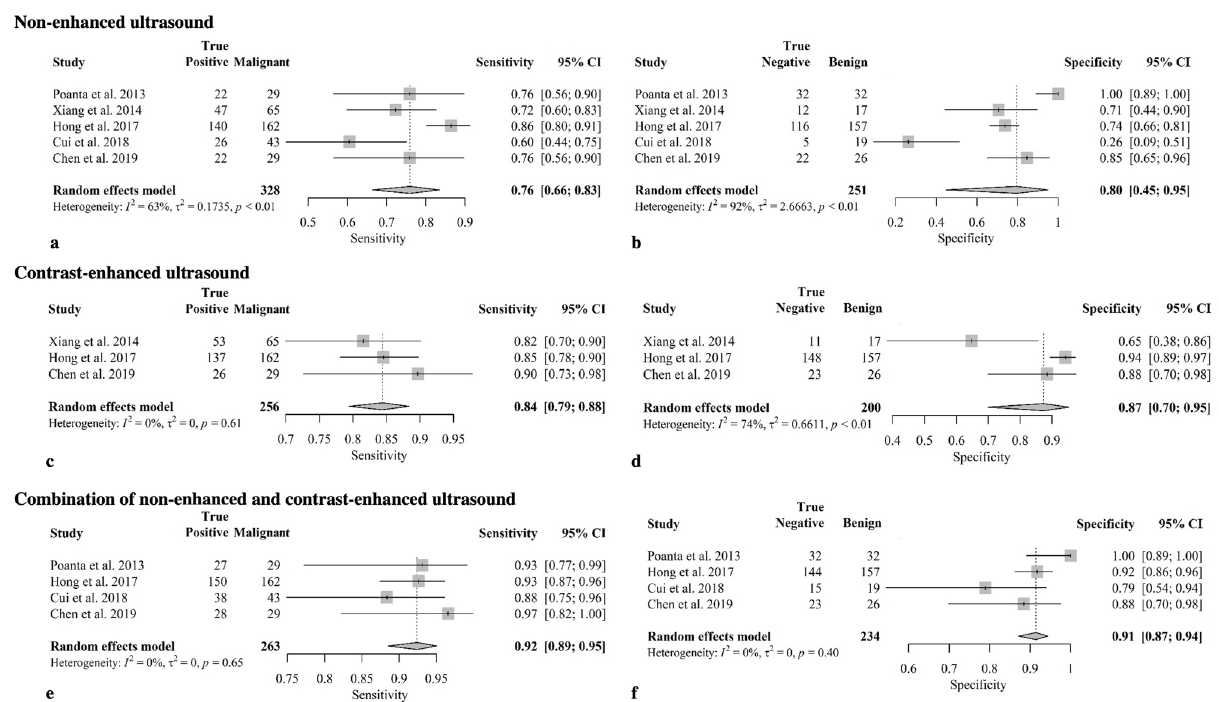
Figure 2. Summary of the diagnostic accuracy of the compared modalities and associated forest plots. The forest plots of the individual compared modalities belonging to the meta-analysis are shown. A distinction is made between non-enhanced US ( a , b ), CEUS only ( c , d ) and their combination ( e , f ). In each group, the achieved sensitivities ( a , c , e ) and the specificities ( b , d , f ) are shown. The width of the individual plots lines is determined by the